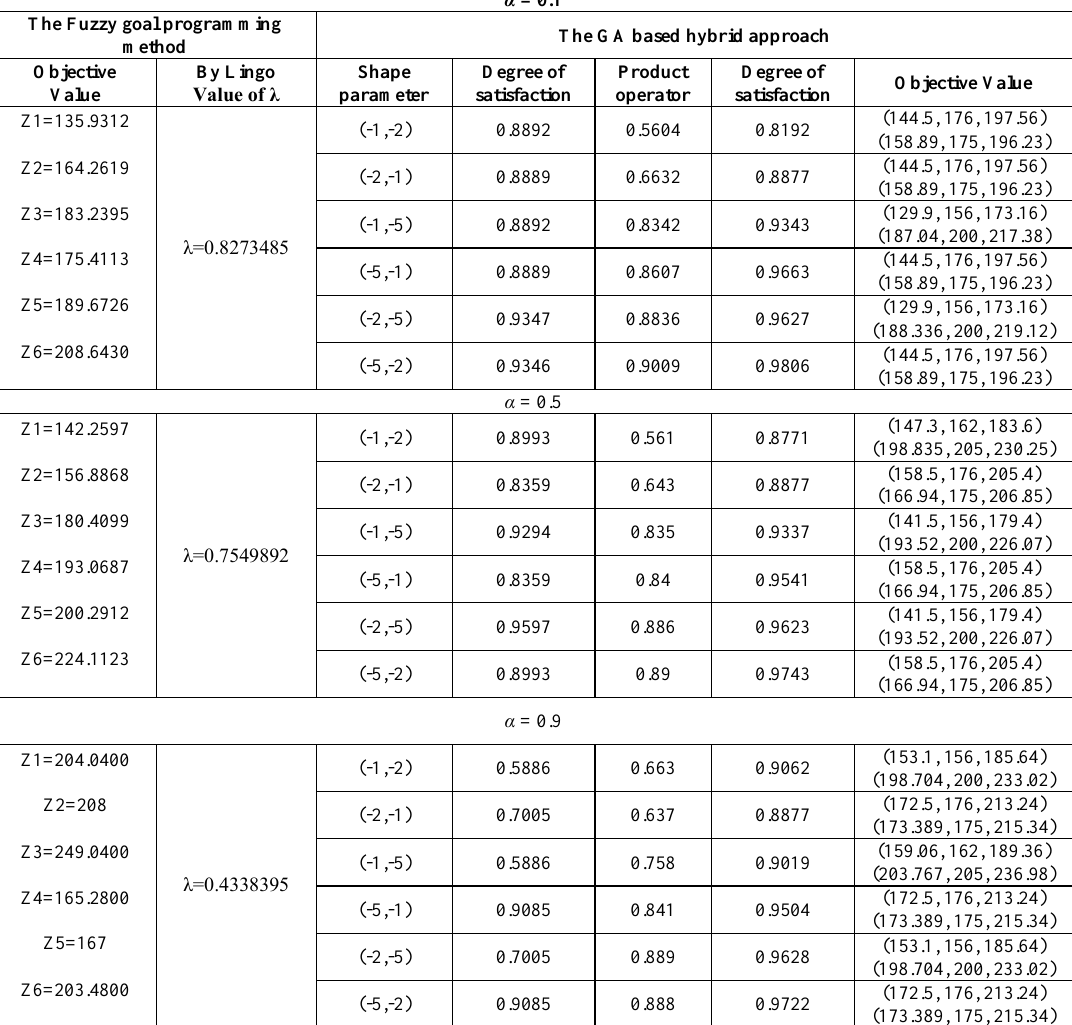
Table 6. Comparison with other